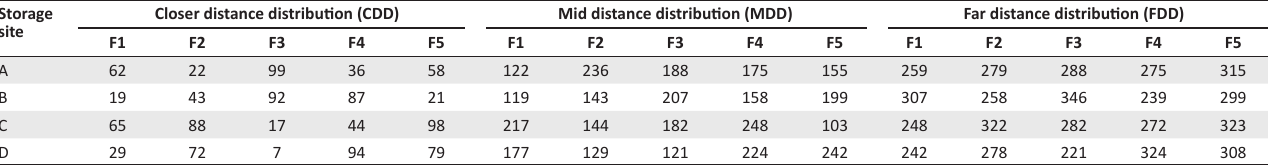
TABLE 5: Distance between storage site and filling stations (km). Storage site